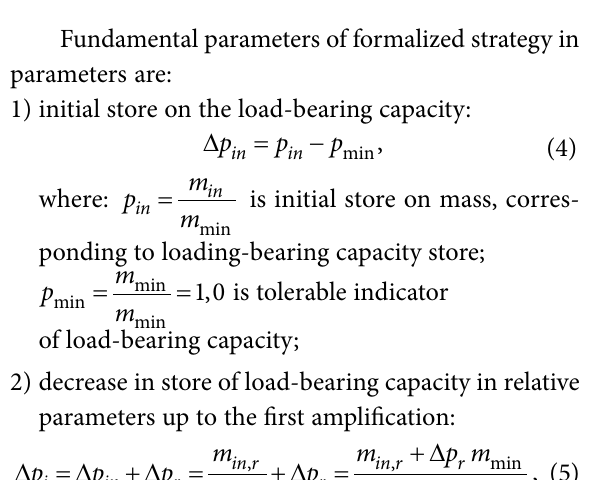
Fig. 2. Strategy formalization of operation in relative